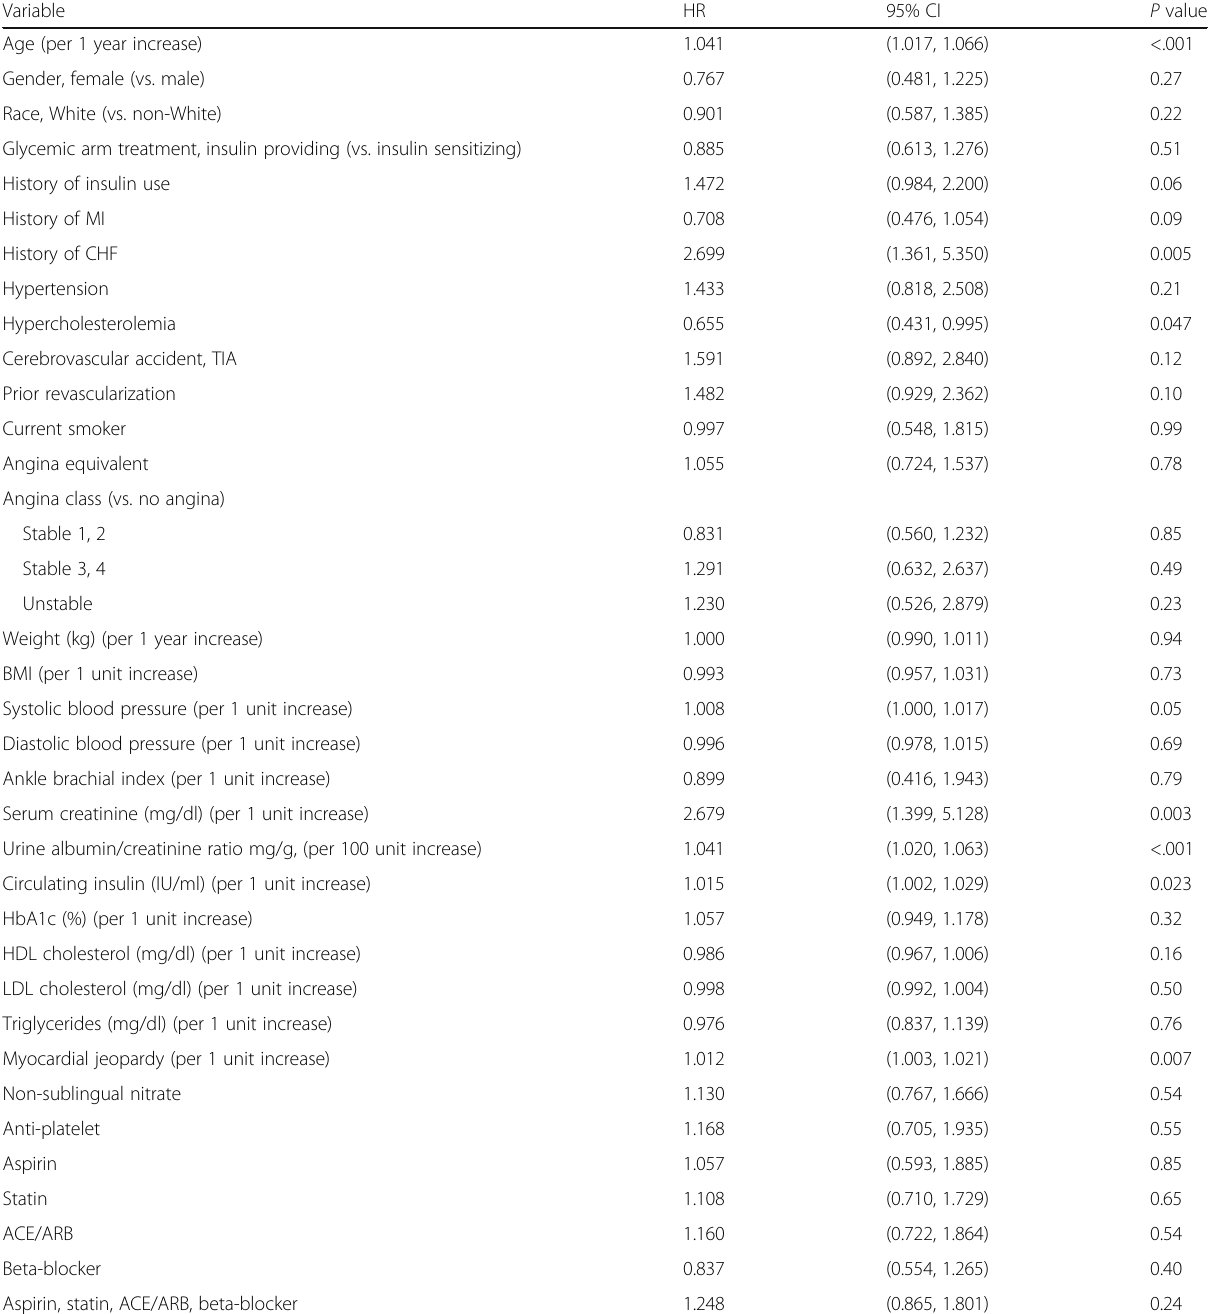
Table 2 Predictors of death/MI/stroke in univariate Cox model Variable HR 95%